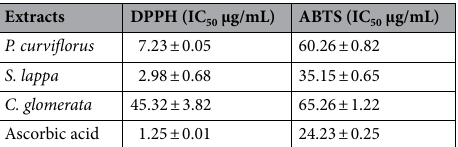
Table 5. Antioxidant activity of P. curviflorus , S. lappa , and C. glomerata